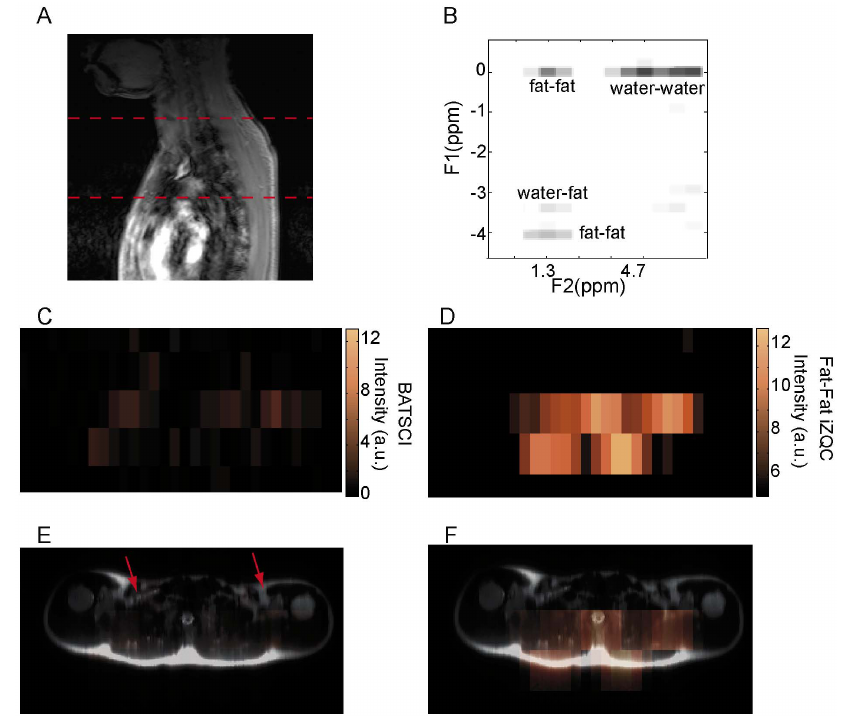
Figure 10. In vivo detection of human BAT in a normal weight subject. ( A ) 2D anatomical image showing the selected slice from which iZQC spectra and images were acquired. ( B ) 2D iZQC spectrum acquired from the same slice (neck/supraclavicular area) of a young male with a BMI of 24.5. ( C ) BATSCI map on the same subject. The BATSCI signal is undetectable and close to the noise level. ( D ) Fat-fat iZQC map on the same subject. The fat-fat iZQC map highlights mainly the subcutaneous fat layer. ( E ) Overlay of BATSCI on spin-echo axial image with red arrows indicating possible BAT locations. ( F ) Overlay of fat –fat iZQC map on spin-echo axial image.